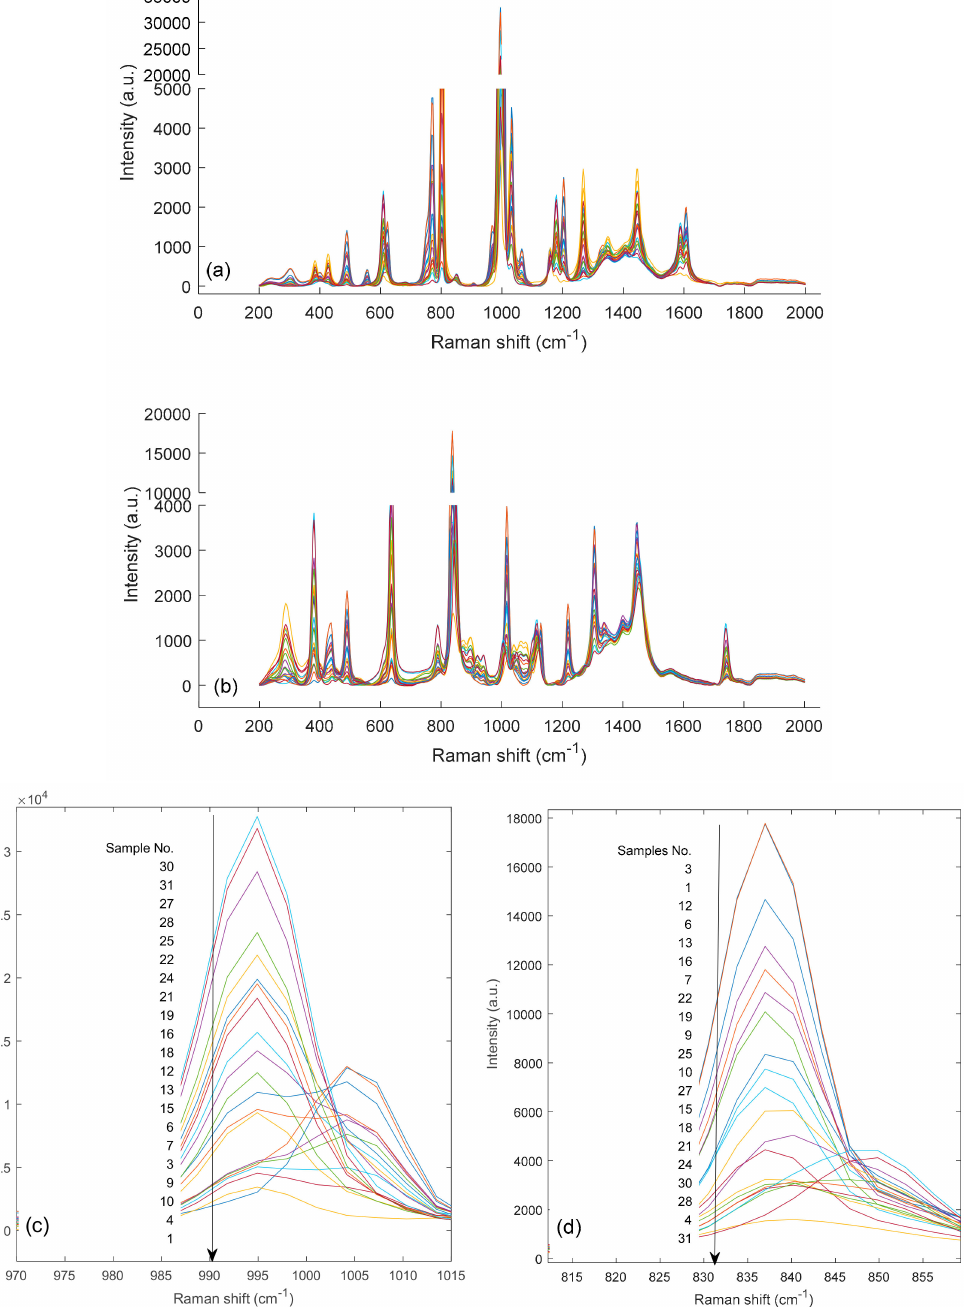
Figure 4. Raman spectra (200–2000 cm − 1 ) of the di ff erent three-component solvent mixtures of system 1 ( a ) and system 2 ( b ). In ( c , d ) enlargements for specific wavenumber ranges of ( a , b ) (see text) are